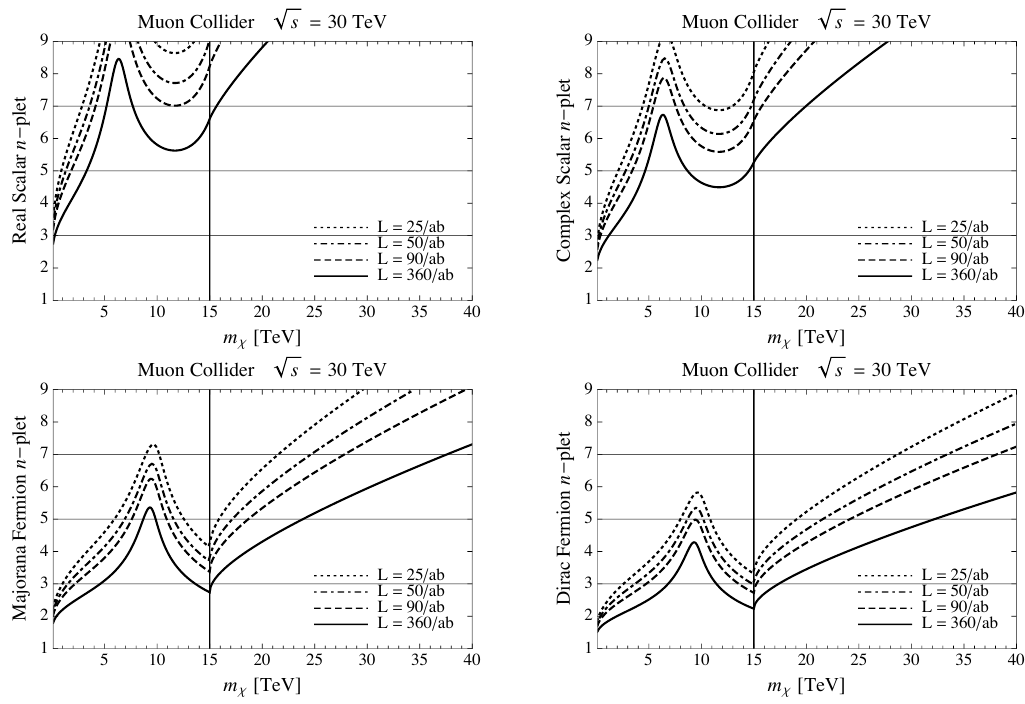
Figure 9 . Expected 95% CL exclusion limits for a 30 TeV muon